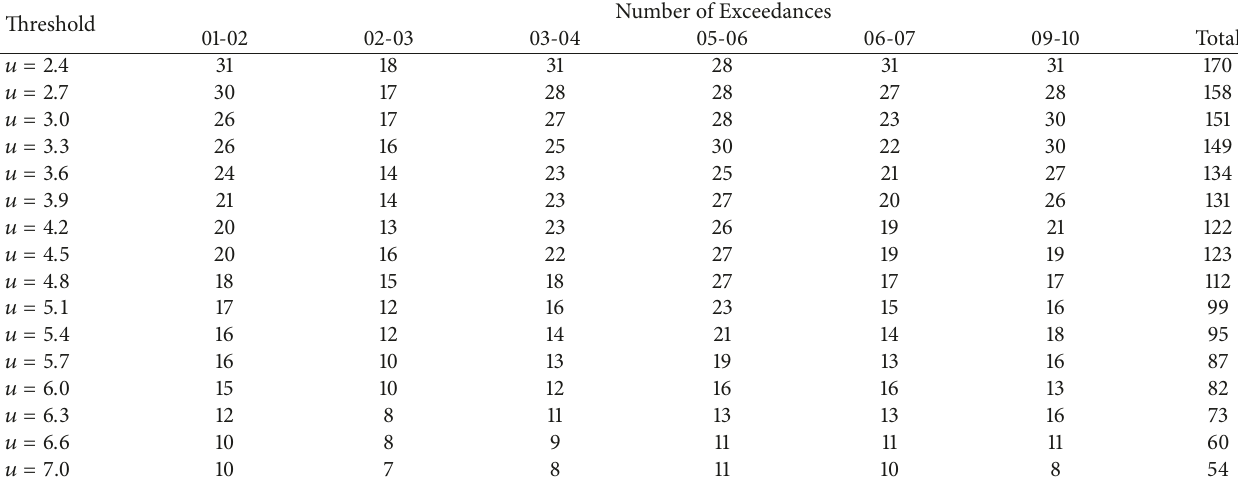
Table 1: Summary of exceedances for various thresholds in POT. Threshold